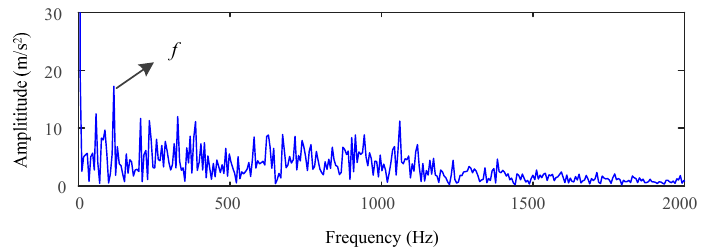
Figure 31. Decomposition results and corresponding frequency spectrum of the IMFs for challenging signal with IVMD. The challenging data is decomposed by CEEMD, VMD, and the proposed IVMD method, respectively. The decomposition results and corresponding frequency spectrums were shown in Figures 29–31. It can be seen from Figures 29–31 that the feature frequency could not be effectively distinguished. Figure 32. Envelope spectrum of optimal component of challenging signal by using CEEMD.